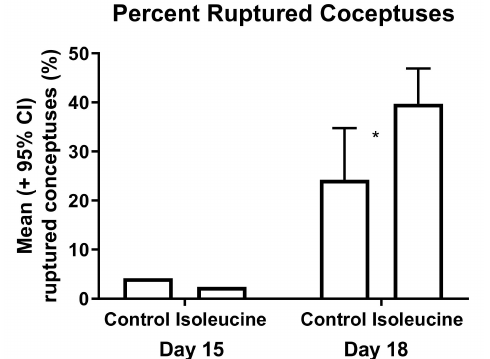
Figure 5. Conceptuses ruptured more frequently than normal (control) during the dissection of the experimental (isoleucine) mice on day 18 of pregnancy (contingency table, p < 0.01; mean ± 95% CI ruptured conceptuses per dam in control vs. isoleucine mice, t-test after arcsine transformation of the data, p < 0.05). A single asterisk (*) indicates mean values that are significantly di ff erent from each other. (See Figures 2 and 4 for sample